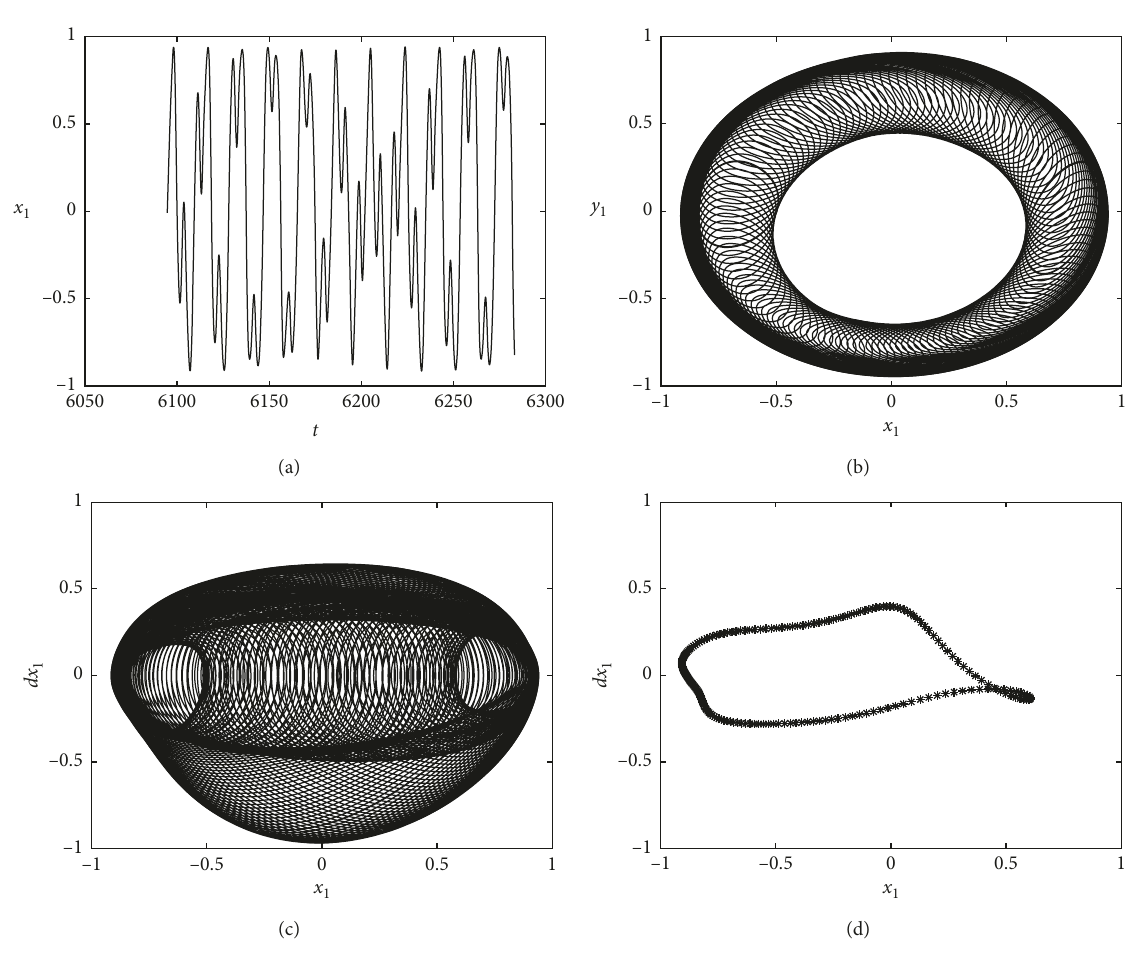
Figure 5: Response of the rotor system when ω �